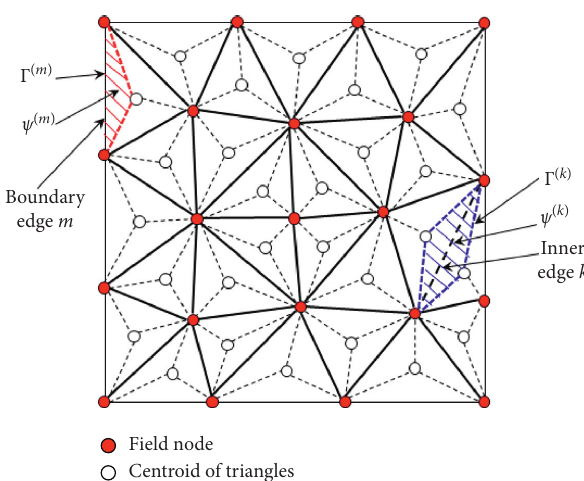
Figure 4: The edge-based smoothing domain ψ k is constructed from triangular